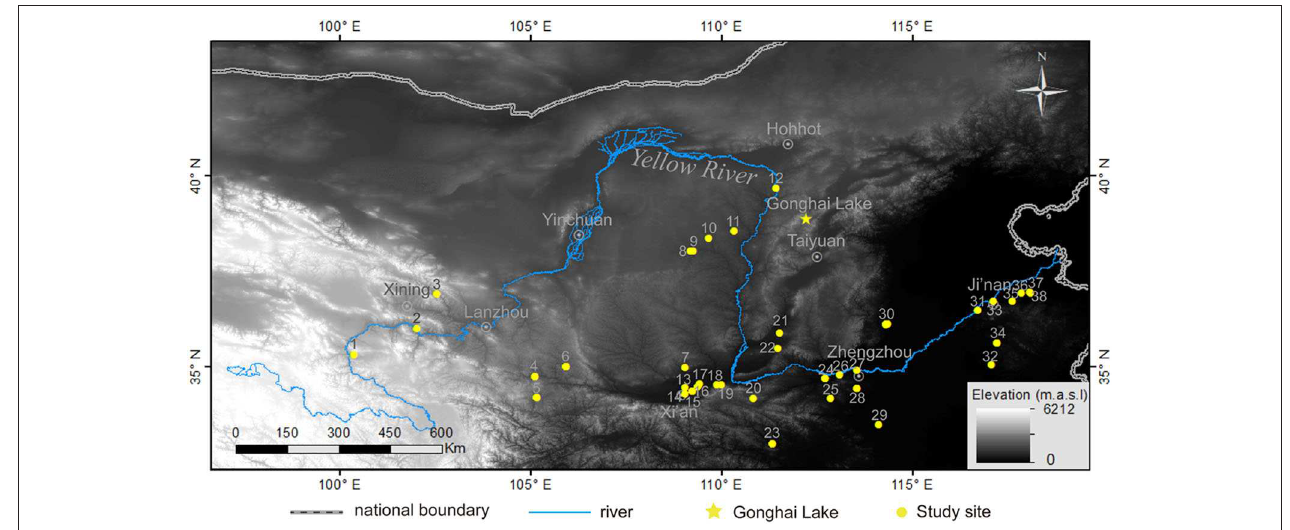
FIGURE 1 | Settlement site locations in China’s Yellow River Valley referred to in this study. 1. Zongri; 2. Andaqiha; 3. Jinchankou; 4. Maojiaping; 5. Xishan; 6. Dadiwan; 7. Wayaogou; 8. Yangjiesha; 9. Dagujie; 10. Huoshiliang; 11. Shimao; 12. Xicha; 13. Yangguanzhai; 14. Kangjia; 15. Jiangzhai; 16. Lingkoucun;